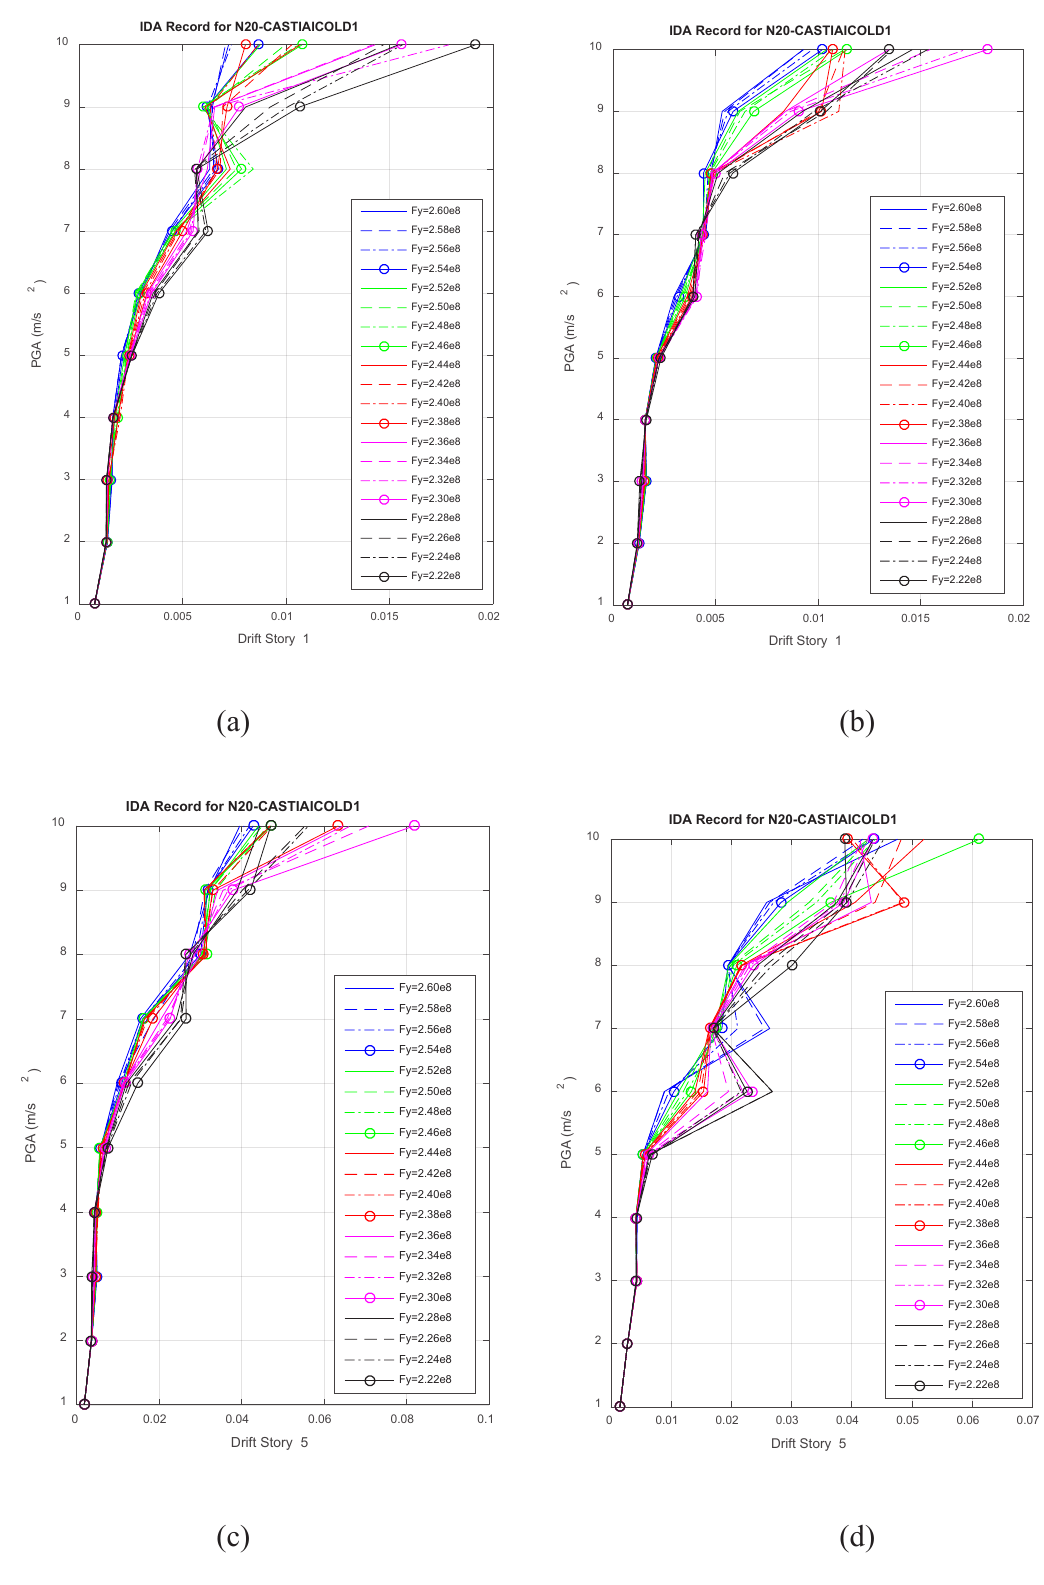
Figure 3: IDA analysis of the (a,b) first, (c,d) fifth, (e,f) tenth, (g,h) fifteenth, and (i,j) twentieth story of the 20-story structure (a,c,e,g,i) not equipped with TMD, and (b,d,f,h,j) equipped with